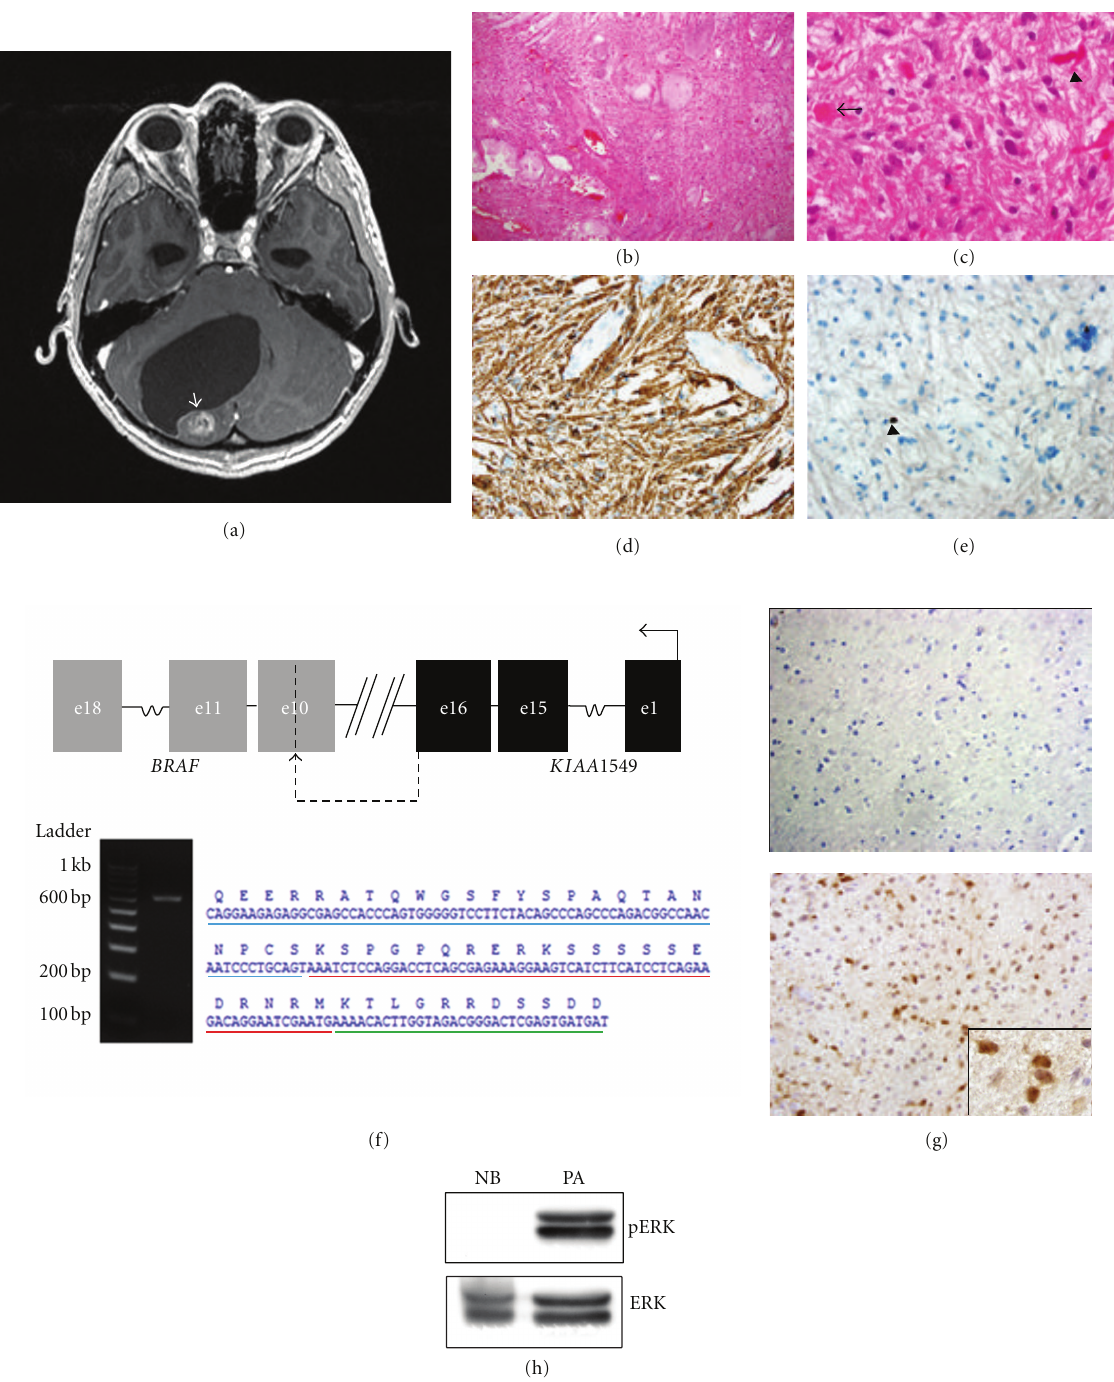
Figure 1: Molecular characterization of a novel KIAA1549:BRAF fusion alteration in a sporadic pediatric pilocytic astrocytoma. (a) Axial T1-weighted 1.5-Tesla gadolinium-enhanced MRI scan reveals a cystic lesion in the cerebellum with a peripheral enhancing nodule (arrow). Hematoxylin and eosin staining demonstrates a classic pilocytic astrocytoma with compact and loose areas (b), including Rosenthal fibers (arrow) and eosinophilic granular bodies (arrowhead) (c). The tumor is composed of cells with strong GFAP expression (d) and rare Ki- 67 immunoreactivity (arrowhead; (e)). Direct amplification of RNA from this tumor demonstrates a 599 bp fragment, which creates a novel fusion KIAA1549 : BRAF transcript in which exon 16 of the KIAA1549 gene is joined to BRAF sequences in the middle of exon 10. The bars below the predicted amino acid sequence correspond to BRAF exon 10 (red), BRAF exon 11 (green), and KIAA1549 exon 16 (blue) (f). Immunostaining with phospho-ERK-Thr 202 /Tyr 204 antibodies demonstrates increased ERK activation in the PA tumor (bottom panel). Normal adult human frontal lobe (NB) from an autopsy specimen was included as reference tissue in the top panel (g). Western blot demonstrates 282-fold increase in ERK activation (phospho-ERK-Thr 202 /Tyr 204 ; p-ERK; Cell Signaling Technologies, catalog no. 4370S) in the tumor (PA) relative to normal human brain (NB). Total ERK is included as internal control for protein loading